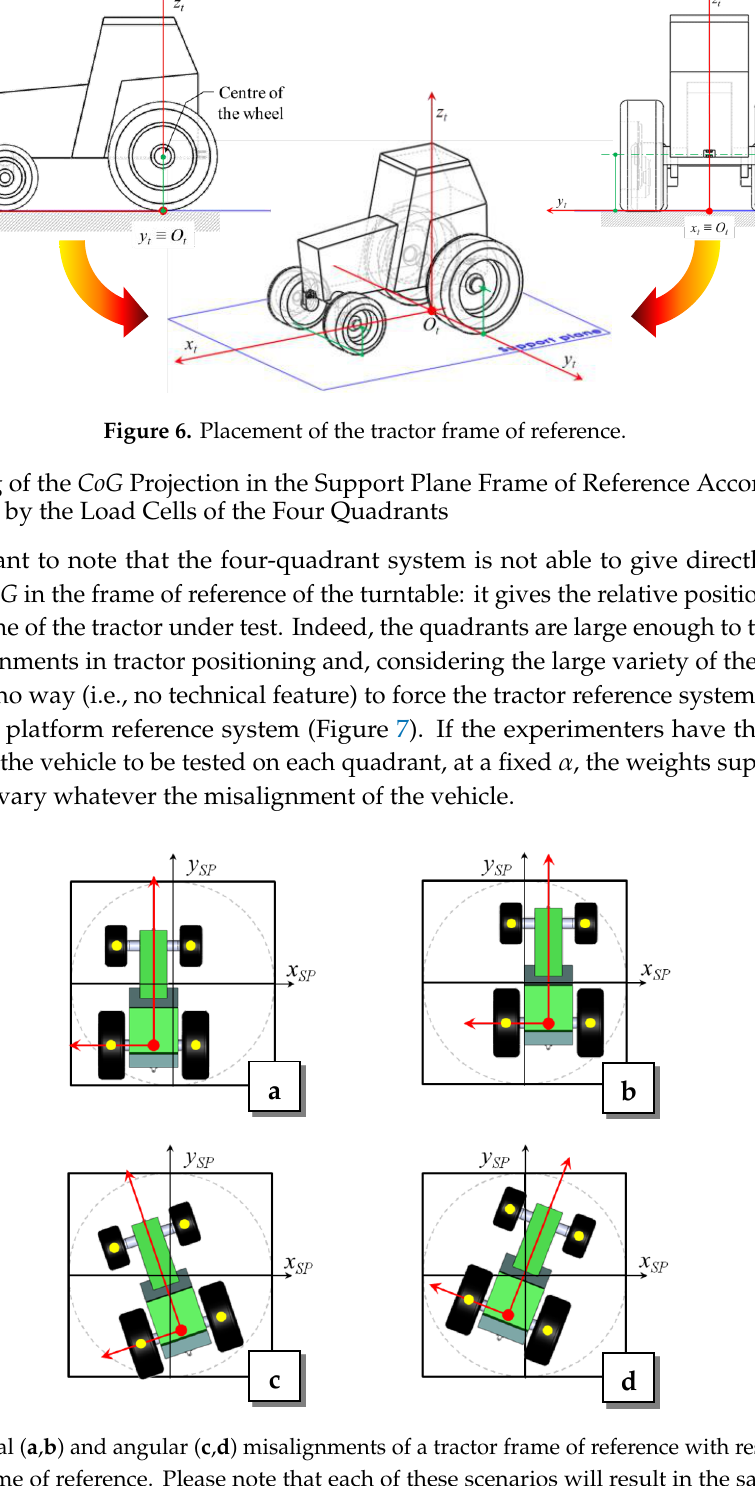
10 of 32 Figure 5. Farm tractor with different widths at the front and rear tracks: in this case L and R are the extremal points and 2 ℓ the length (i.e., the vehicle width) of the segment perpendicular to the longitudinal axis in correspondence of the projection of the center of gravity (CoG′). 3.4. Completely Static Operative Mode of the Test Rig 3.4.1. Setting of a Frame of Reference Fixed to the Vehicle The vehicle frame of reference x t -y t -z t -O t can be assumed oriented as follows (Figure 6):  x t axis: aligned with the tractor median axis, contained in the tractor support plane; 